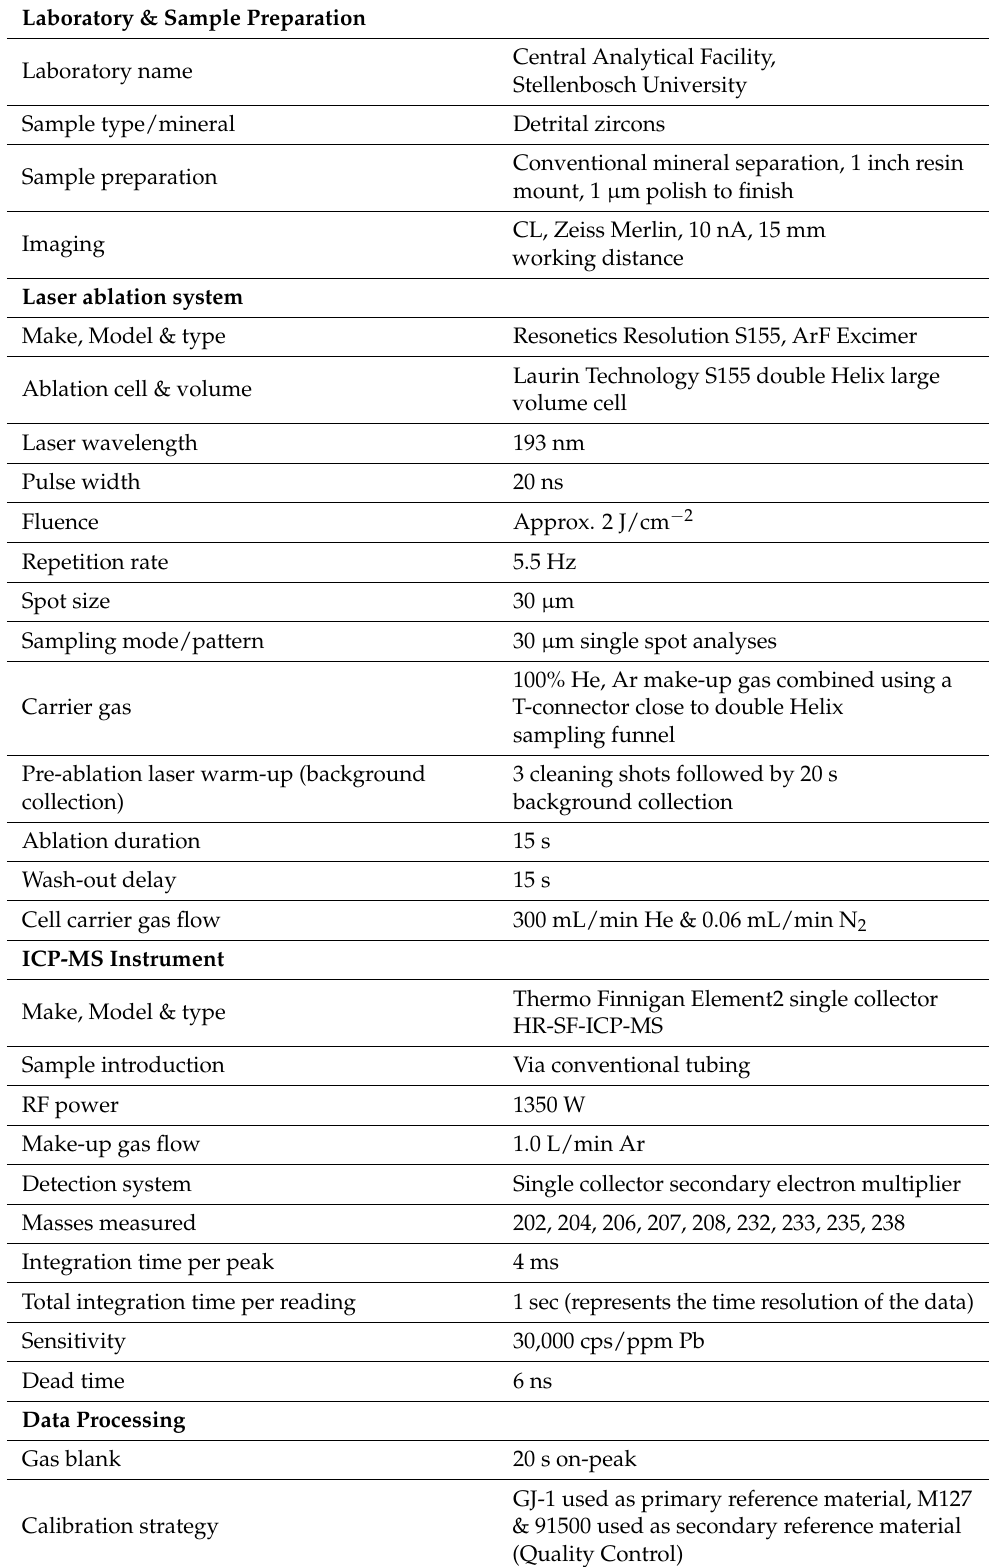
Table 1. LA-SF-ICP-MS U-Th-Pb dating methodology for zircons discussed in this